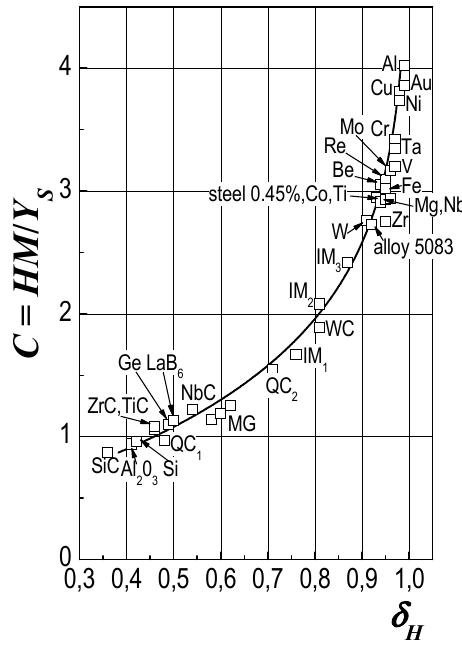
Figure 3. Relation between the Tabor parameter C = HM/Y S and the plasticity characteristic δ H . Curve was constructed on the basis of Equation (13) for z = 0.38 and ν S = 0.27.